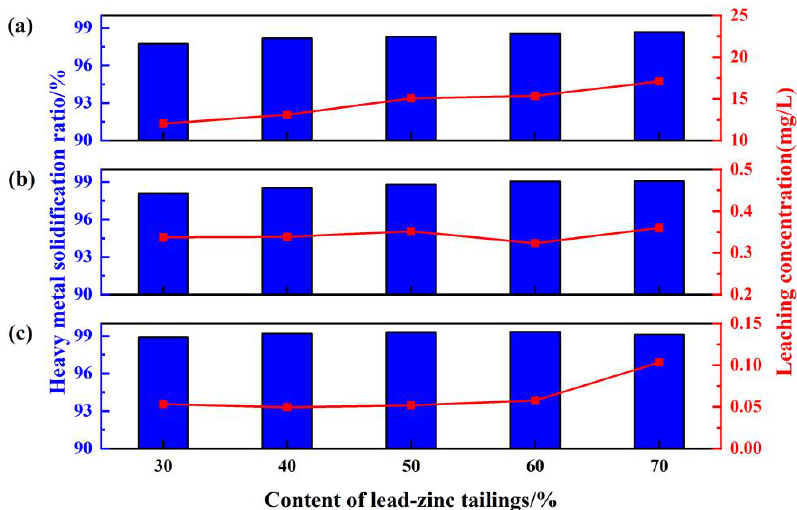
Figure 3. Solidification rate and leaching concentration of Zn 2+ ( a ), Pb 2+ ( b ), and Cd 2+ ( c ) in geopolymers with different tailings contents [85].